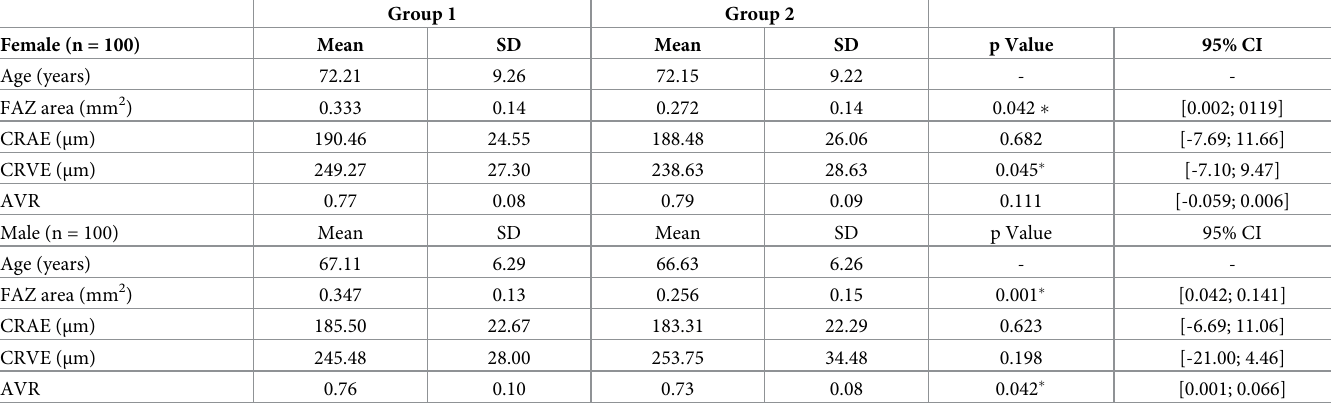
Table 3. Summary of fluorescein angiography measurements for Group 1 and Group 2 dependent on gender.